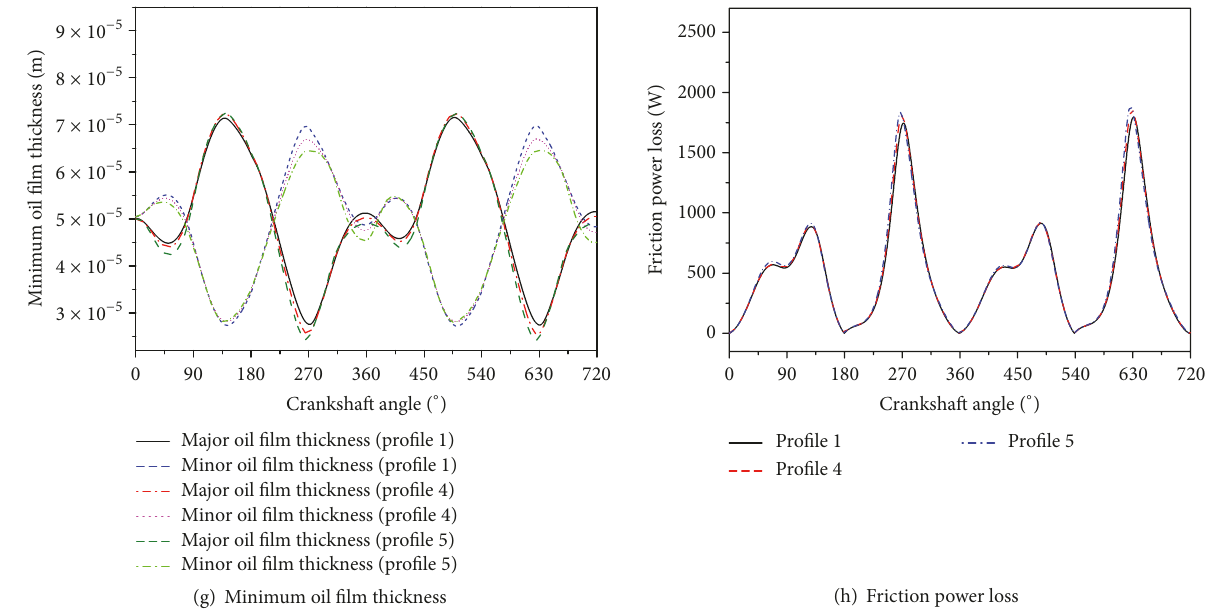
Figure 14: Effect of radial reduction on lubrication performance.